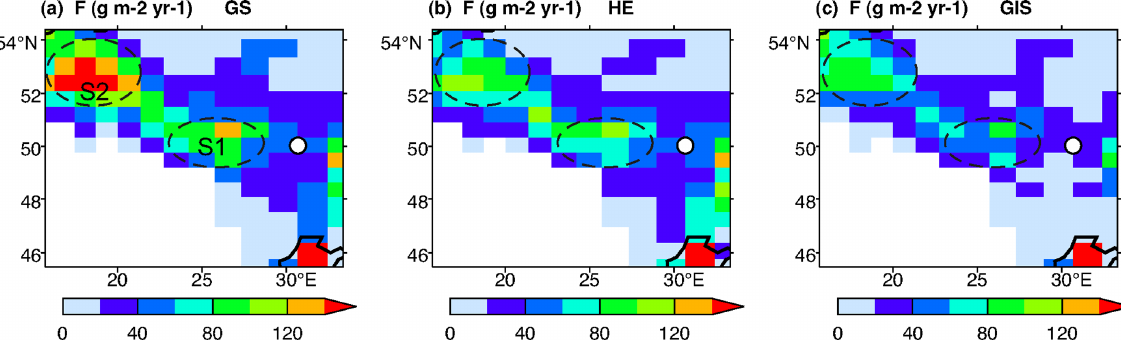
Fig. 4. Annual means of dust emission fluxes F (gm − 2 yr − 1 ), calculated including the vegetation effect, for the three simulated climate states: GS (left panel), HE (middle panel), and GIS (right panel). Emission mainly occurs in a NW–SE band, with S1 and S2 being the most active spots.